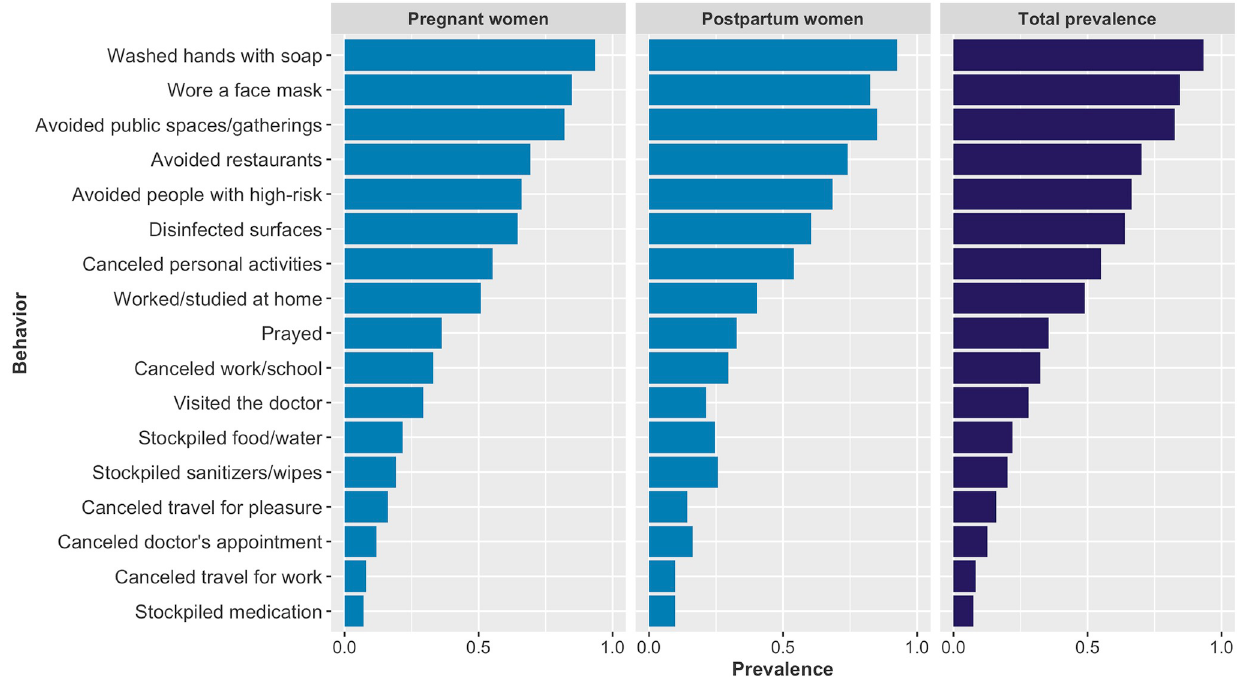
Fig 5. Prevalence of COVID-19 prevention related behaviors for pregnant and postpartum women.